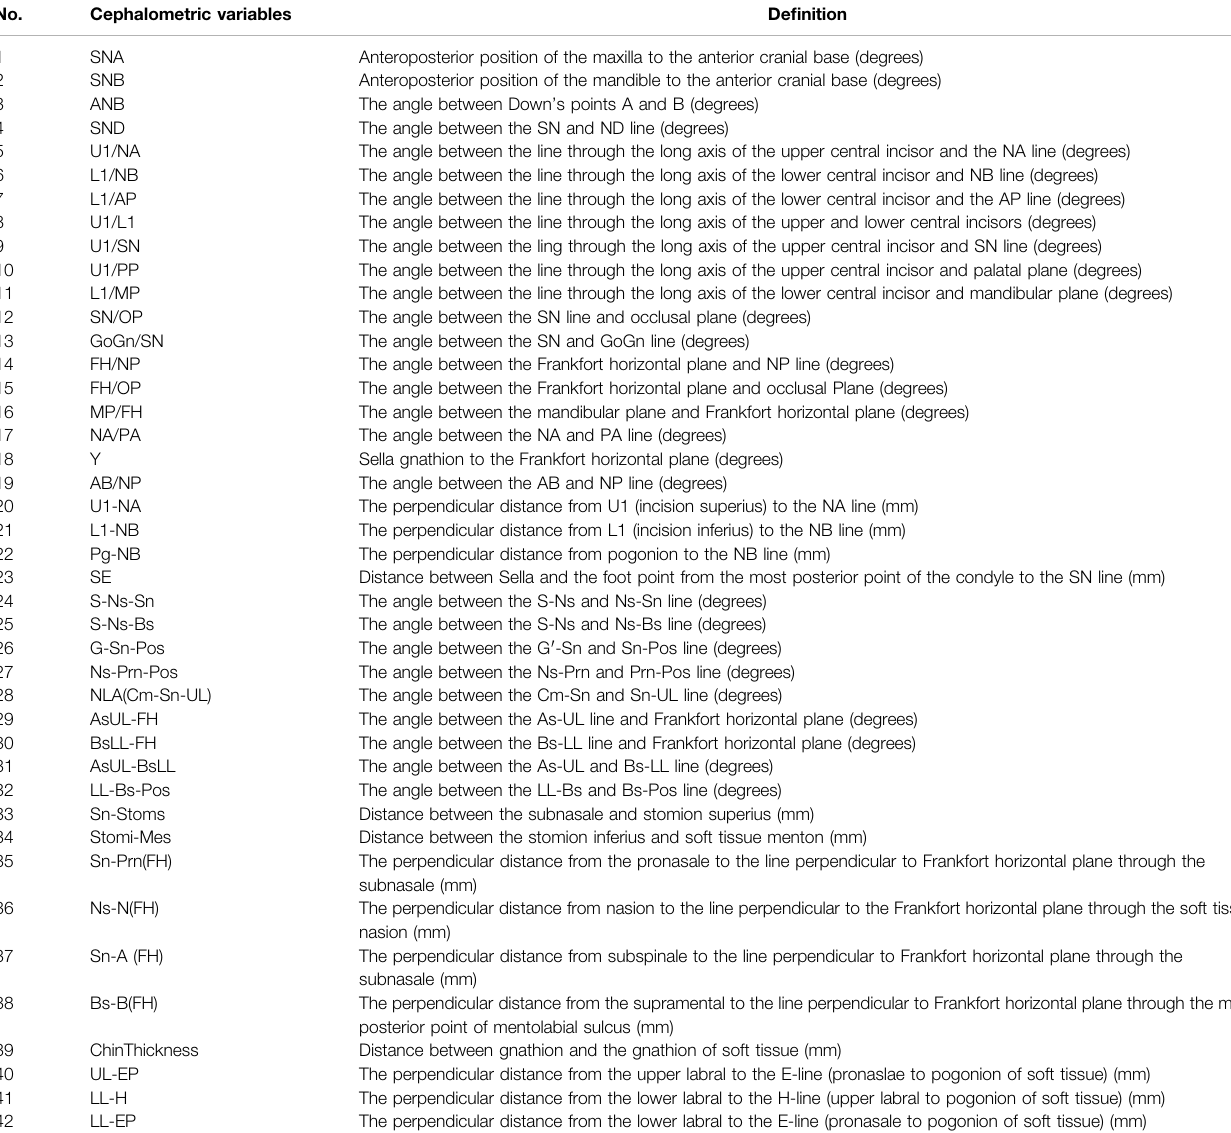
TABLE 1 | De fi nitions of the 42 cephalometric features.